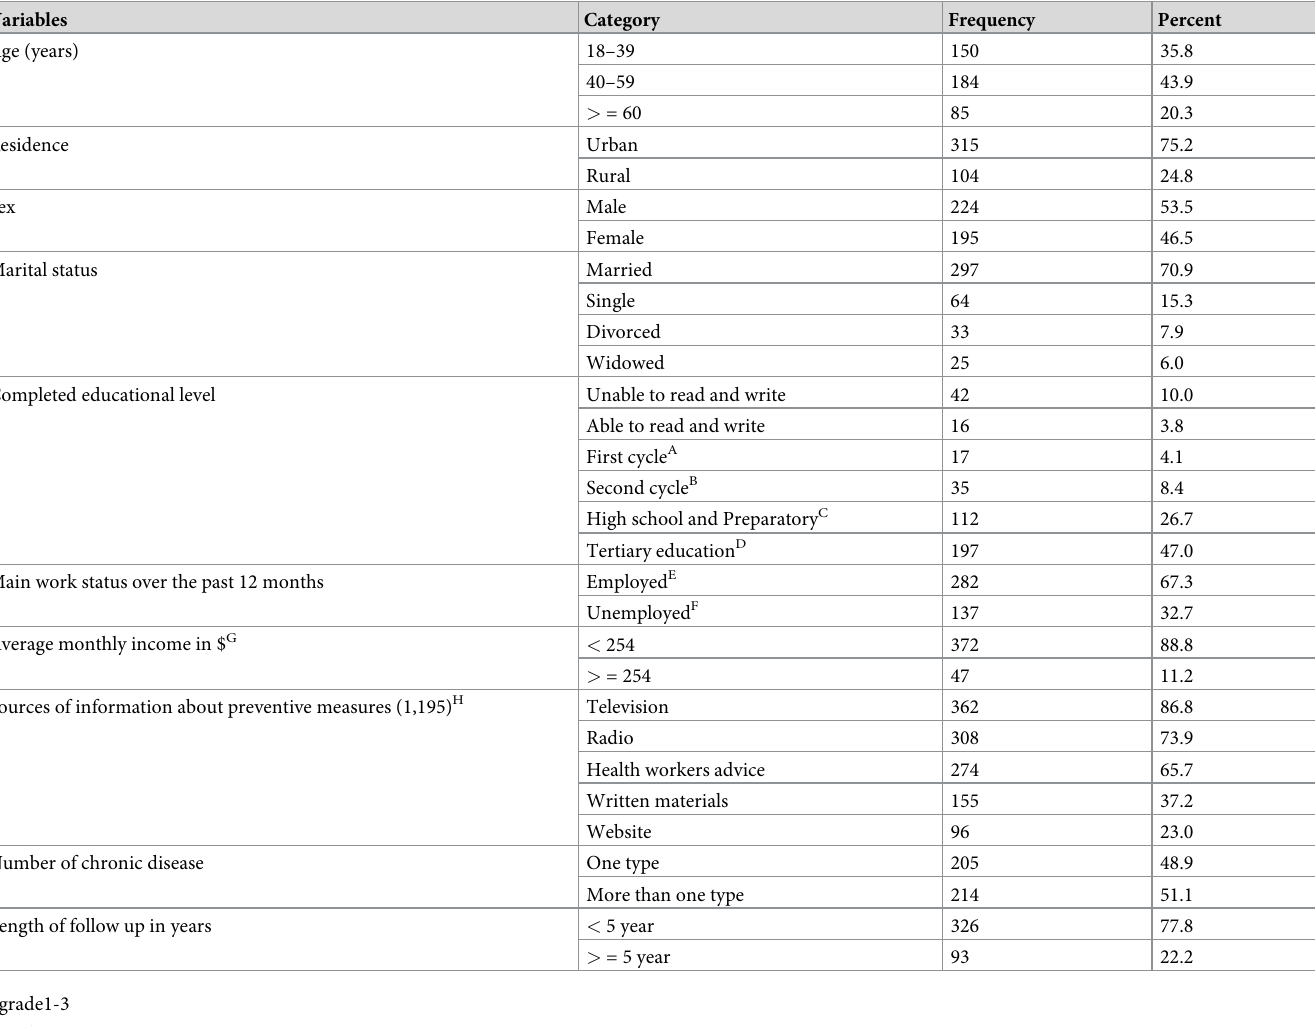
Table 1. Socio-demographic and clinical characteristics of the study participants (n =